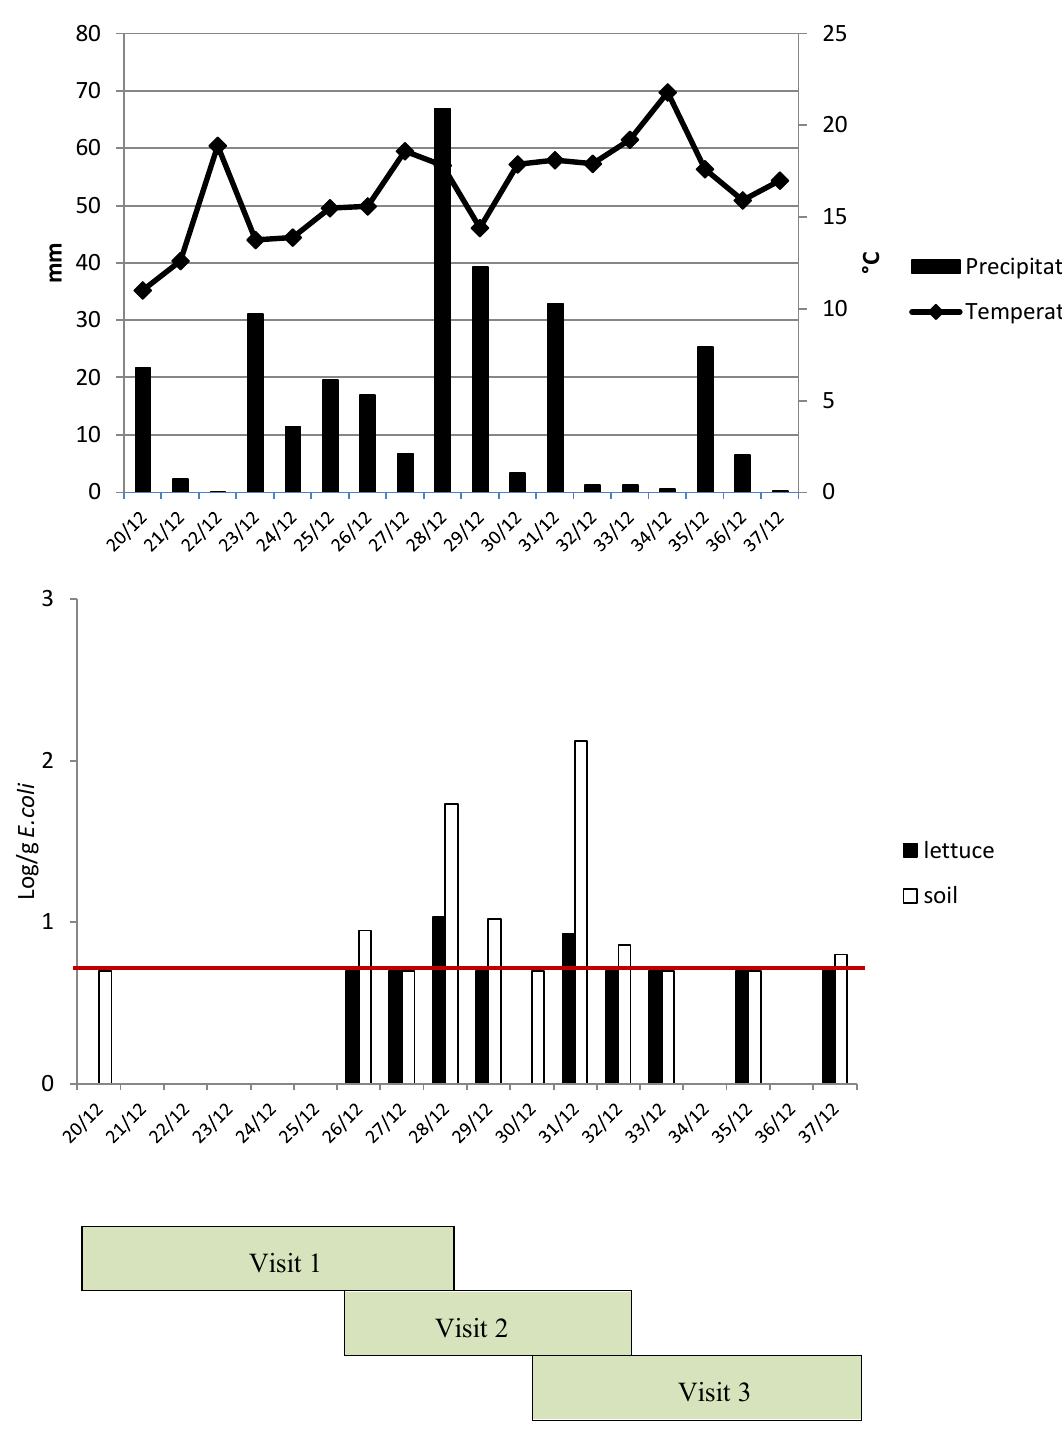
Figure 5. Impact of precipitation and temperature on the presence of indicator bacteria in soil and lettuce during the three visits (starting in week 20 with visit 1 up to week 37 with visit 3) of farm 6; the red line is the detection limit (0.7